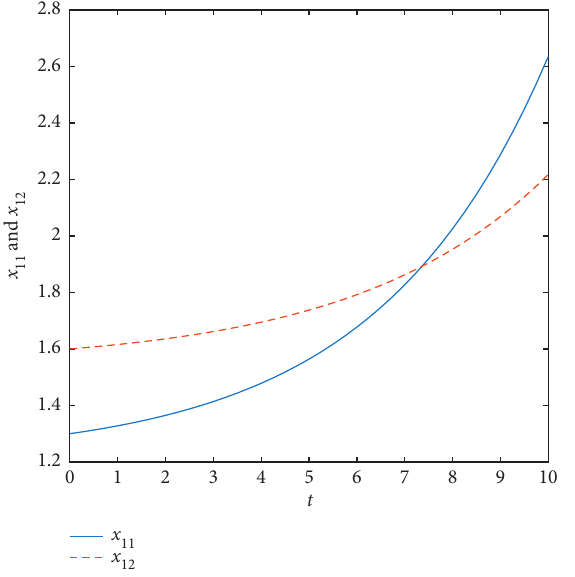
Figure 8: The pollution stock trajectory of the upstream region under noncooperation.